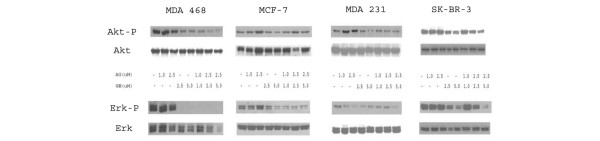
Effect of treatment on Erk and Akt kinases phosphorylation and protein levels. Western blot analysis showing phosphorylation (P) (top) and protein (bottom) levels of Akt and p44/p42 Erk kinases in cells treated for 24 hours with AG1024 (AG), gefitinib (GE), or both.